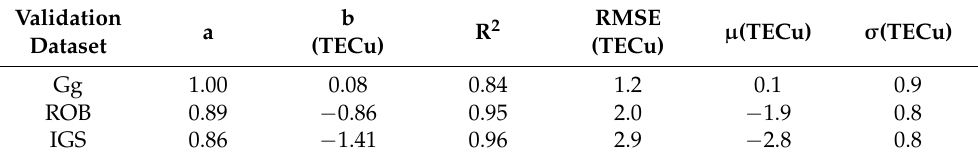
Figure 4. The same as Figure 2 but referring to the IONORING validation against the Global Ionospheric Maps (final products) provided by the International GNSS Service (IGS). The linear fit (red-dashed line) and its features (in the textbox) are reported, while the blue line indicates the bisector (panel a ). Time profile of the difference between IONORING and IGS vTEC (panel b ). Probability distribution of the difference between IONORING and IGS vTEC and the corresponding Gaussian fit (red), whose expression and parameters are also reported in the textbox (panel c ). Boxplots of the hourly (panel d ) and monthly (panel e ) differences between IONORING and IGS vTEC. In the boxplots, the red line indicates the median, and the bottom and top edges of the box indicate the 25th and 75th percentiles, respectively, while the range marked by the dashed lines indicates the extrema. Table 1. Summary table of the validation